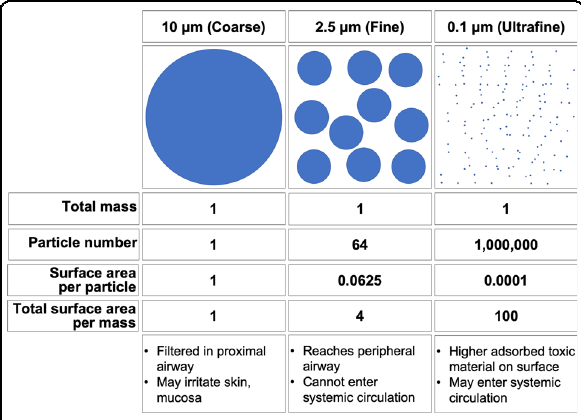
Fig. 1 Comparison of the surface area of particles with different diameters. The diagram assumes that all particles in each category are perfect spheres, have the same density, and are present in an equal amount of mass. The mass, particle number, and surface area of coarse particles are all arbitrarily designated as 1. Other numbers are relative to the coarse particle. The large surface area and ability to enter circulation are the two most signi fi cant characteristics of ultra fi ne particles that make them more toxic than other larger particles. Fig. 2 Particle-size distribution of atmospheric PM. A schematic